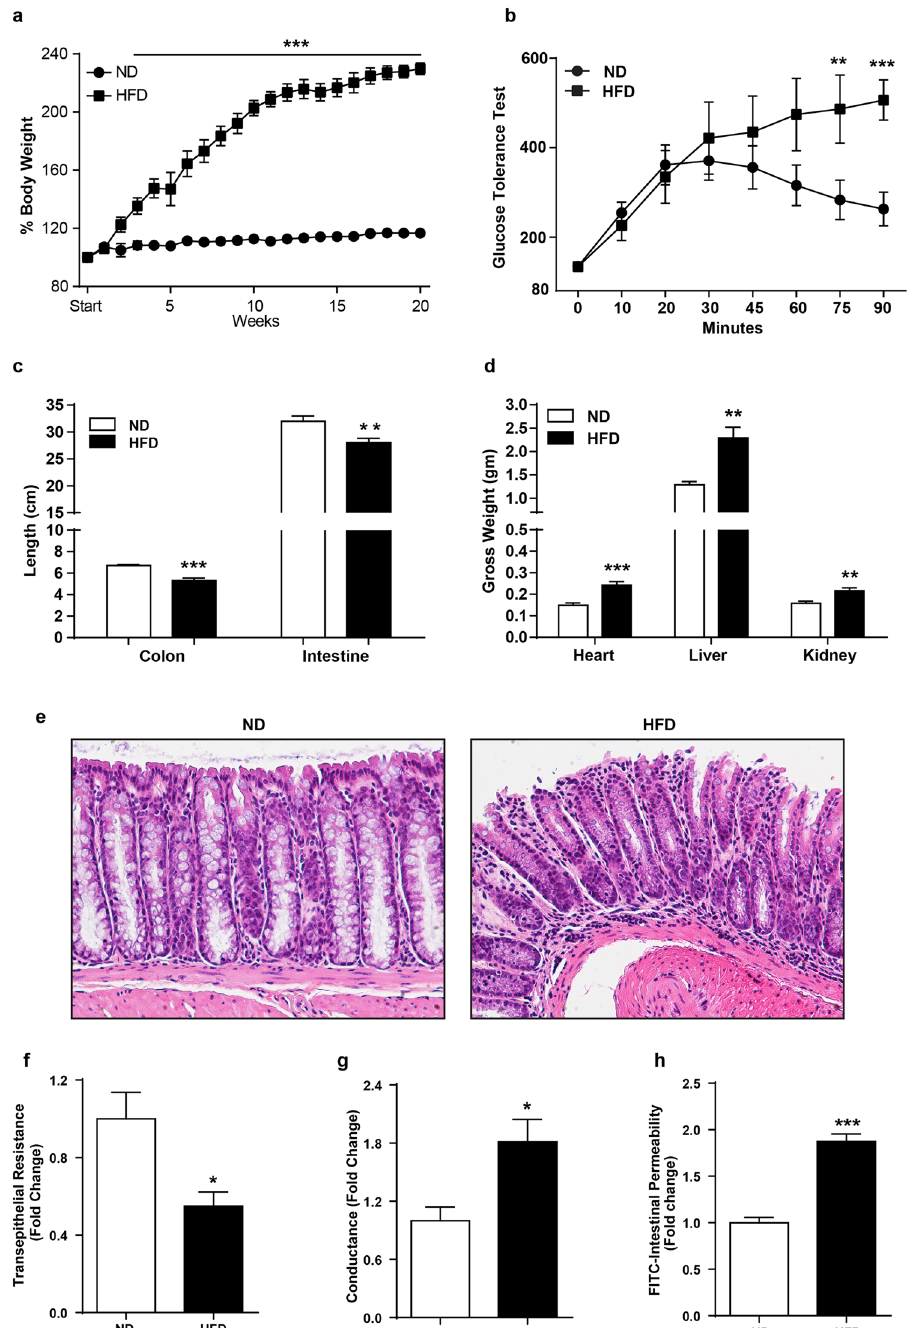
Figure 1. High fat diet induces obesity and associated metabolic and physiological changes in C57/BL6 mice. 8 – 10 weeks old mice were subjected to normal chow or high fat diet for 20 weeks ( N = 8 ). ( a ) body weight changes in mice over the period of ND- or HFD-diet feeding; ( b ) Oral glucose tolerance test (OGTT); ( c) Changes in colonic and intestinal length in HFD-versus ND-fed mice; ( d ) Changes in organ weight in HFD-versus ND-fed mice; ( e ) Representative images showing immune cell infiltration in mice colon with HFD- versus ND-mice. ( f and g ) Colonic trans-epithelial resistance and conductance across the mucosal sheet changes during HFD-mice versus control; ( h ) Intestinal permeability (for FITC-dextran) in HFD versus ND-mice. Values are presented as mean ± SEM *** P ≤ 0.001, ** P ≤ 0.01 and * P ≤ 0.05 compared to control mice on